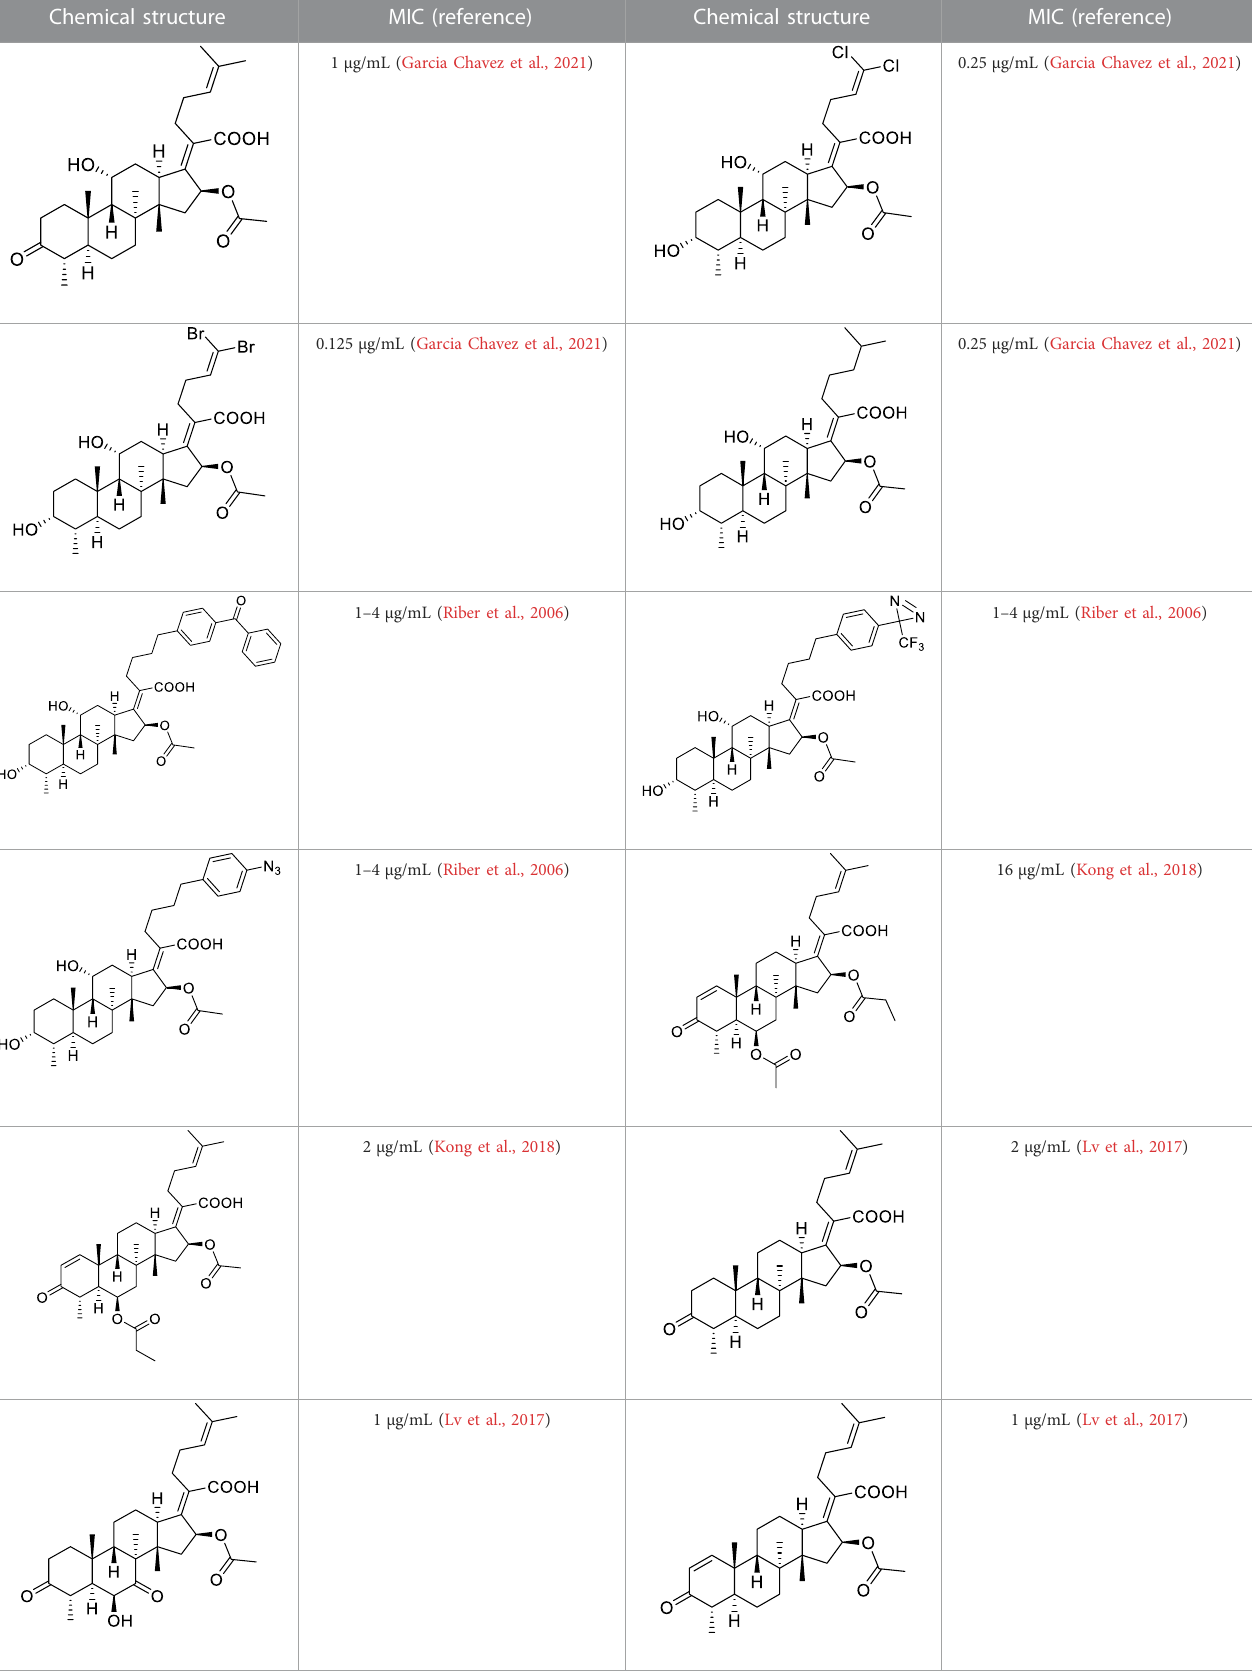
TABLE 5 Known FA derivatives with notable antibacterial activities used to generate a pharmacophore